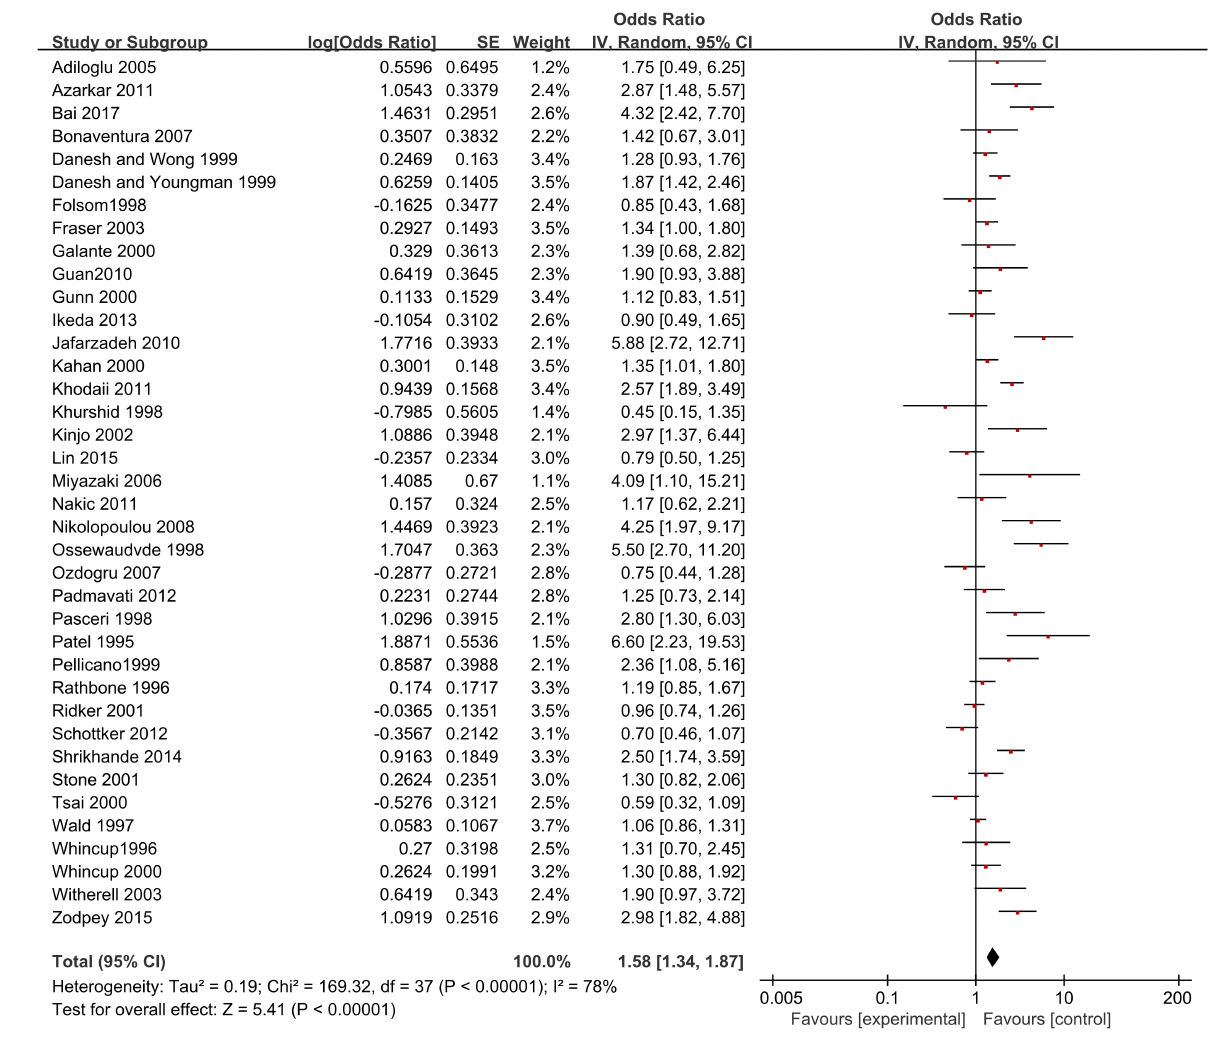
Frontiers in Cardiovascular Medicine |